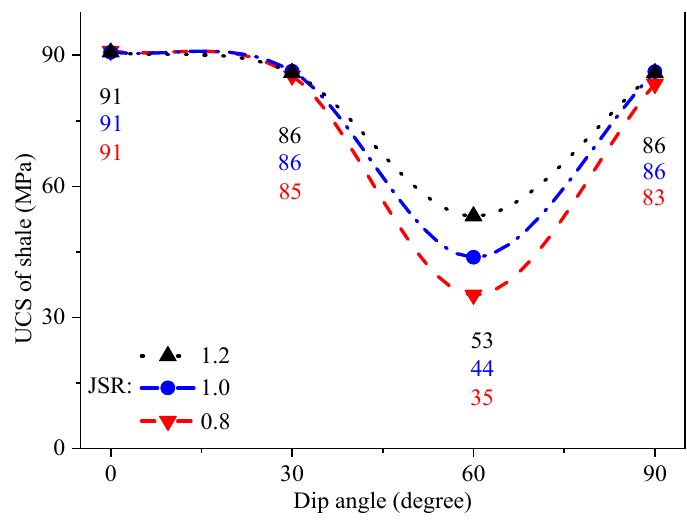
Figure 8. Variations of uniaxial compressive strength with dip angle at different JSR.